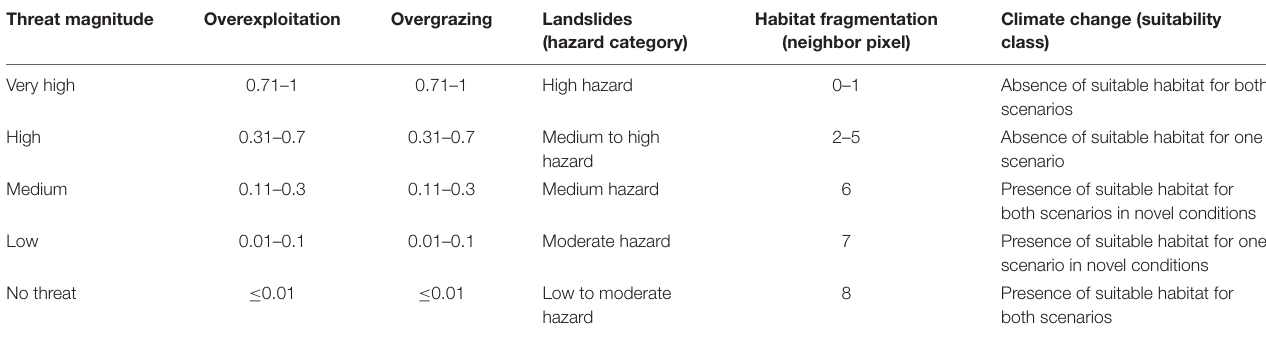
TABLE 3 | Threat levels and applied criteria to transform the threat intensity into threat